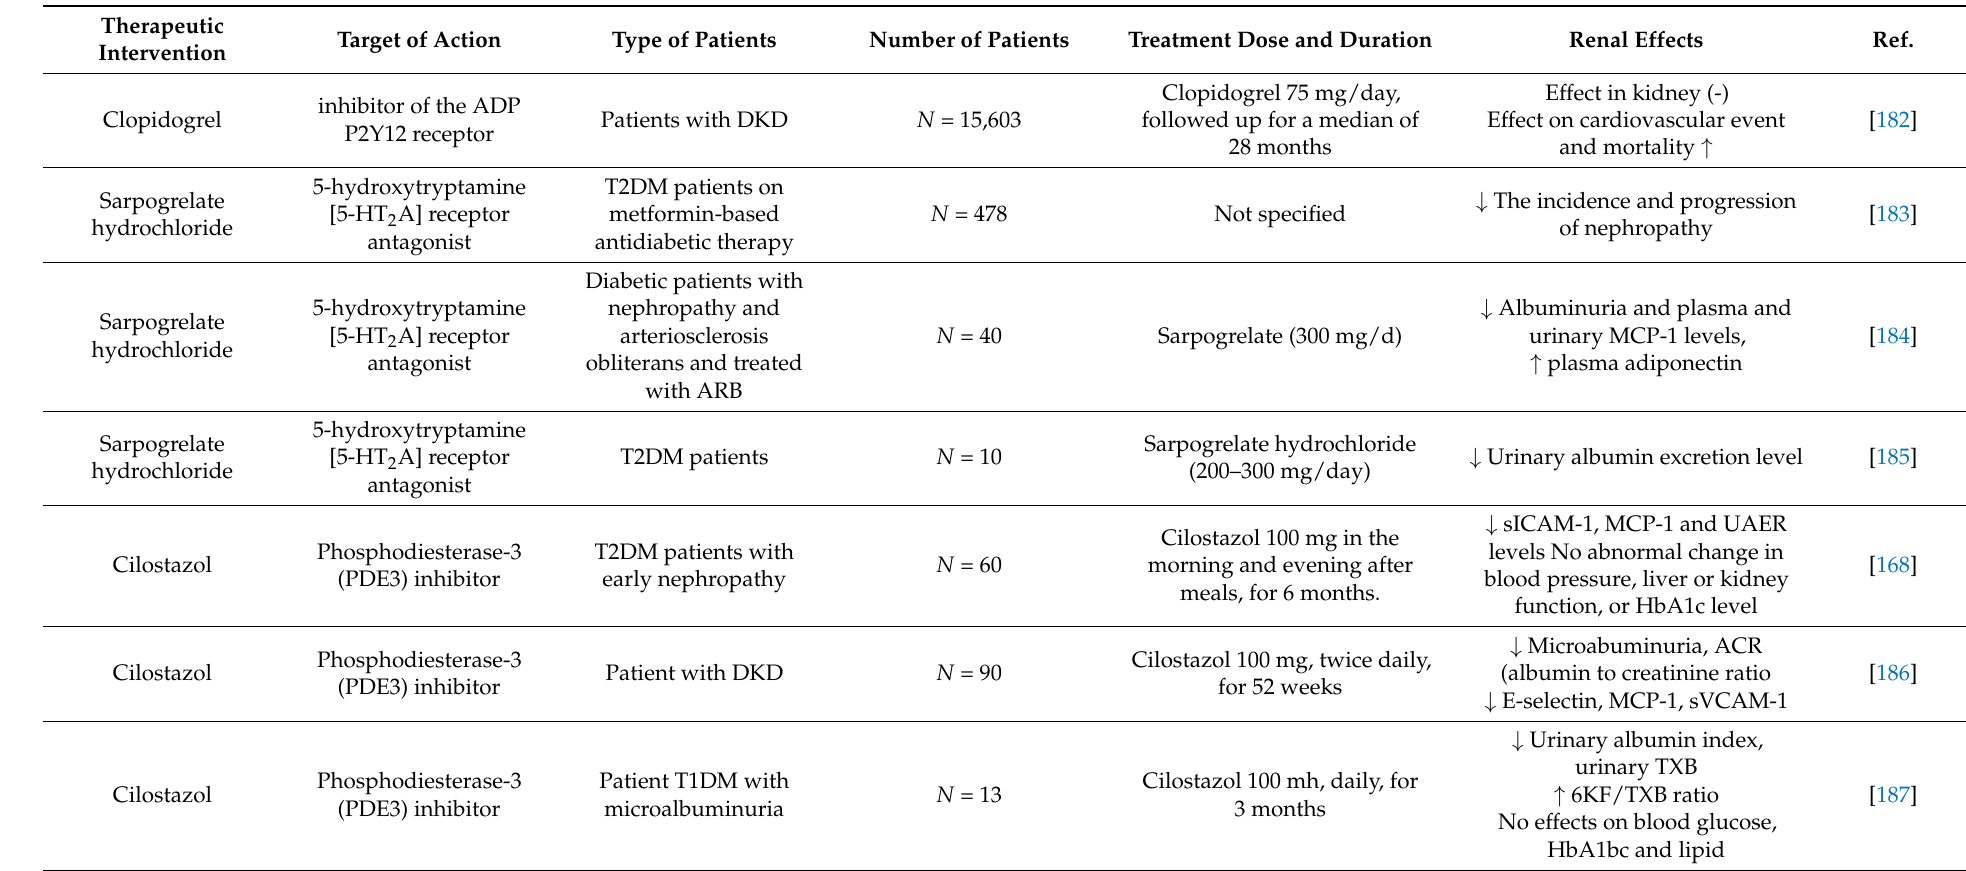
Table 4. Antiplatelets drug therapy in human studies of diabetes kidney